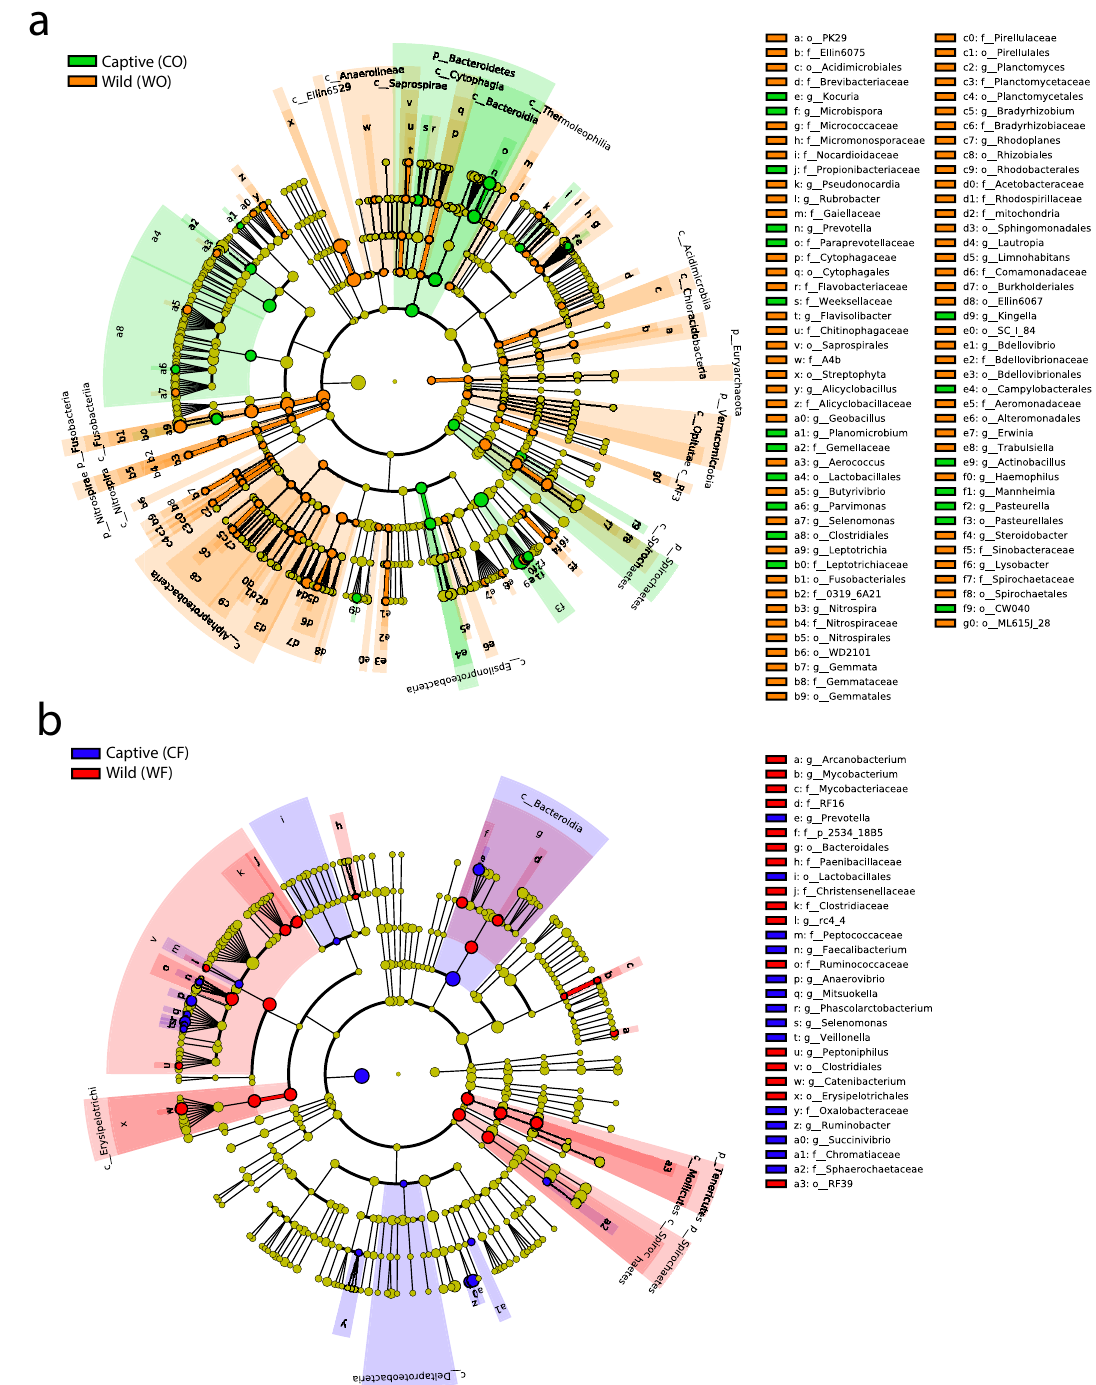
Figure 3. Differential abundance analysis comparing the taxa within wild and captive macaques. The cladogram illustrated the results from Linear discriminant analysis Effect Size (LEfSe) analysis showing the significantly differential taxa (LDA score > 3, P < 0.01) in ( a ) Oral microbiome and ( b ) Fecal microbiome. The circle nodes represented the classified taxa and their taxonomic relationship. From the center to the periphery of cladogram, each level represented the taxonomic rank, with phylum, class (c), order (o), family (f) and genus (g), respectively. The size of node proportionally indicated the relative abundance of each taxon. The taxa with no significant differences were represented by yellow color. The other significant different taxa enriched in each group were illustrated by different colors (green = CO, orange = WO, blue = CF, red =